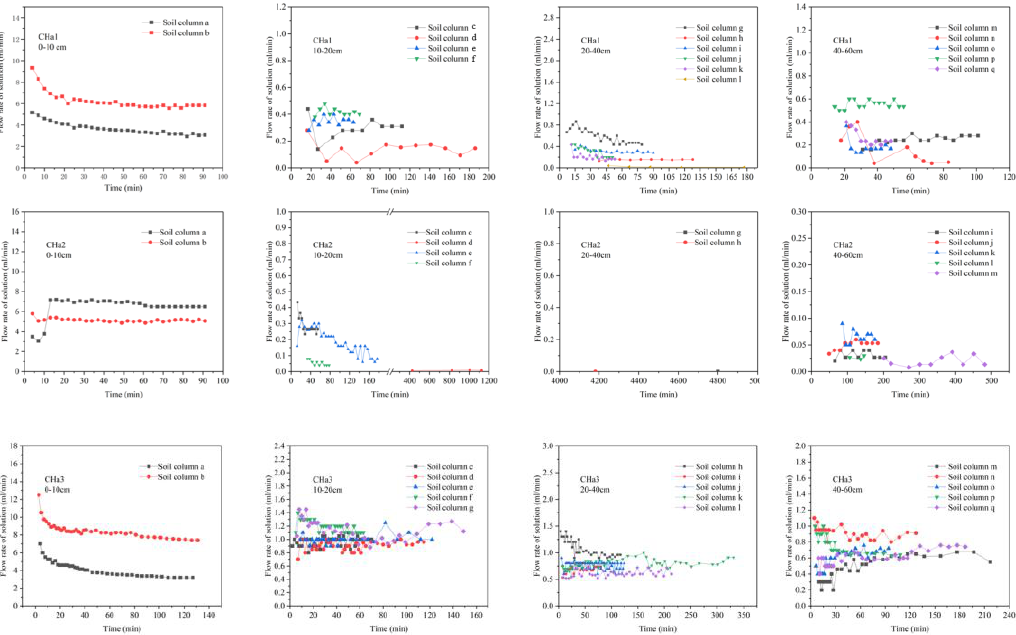
Figure 2. Variation of outflow rate of Robinia Pseudoacacia communities with